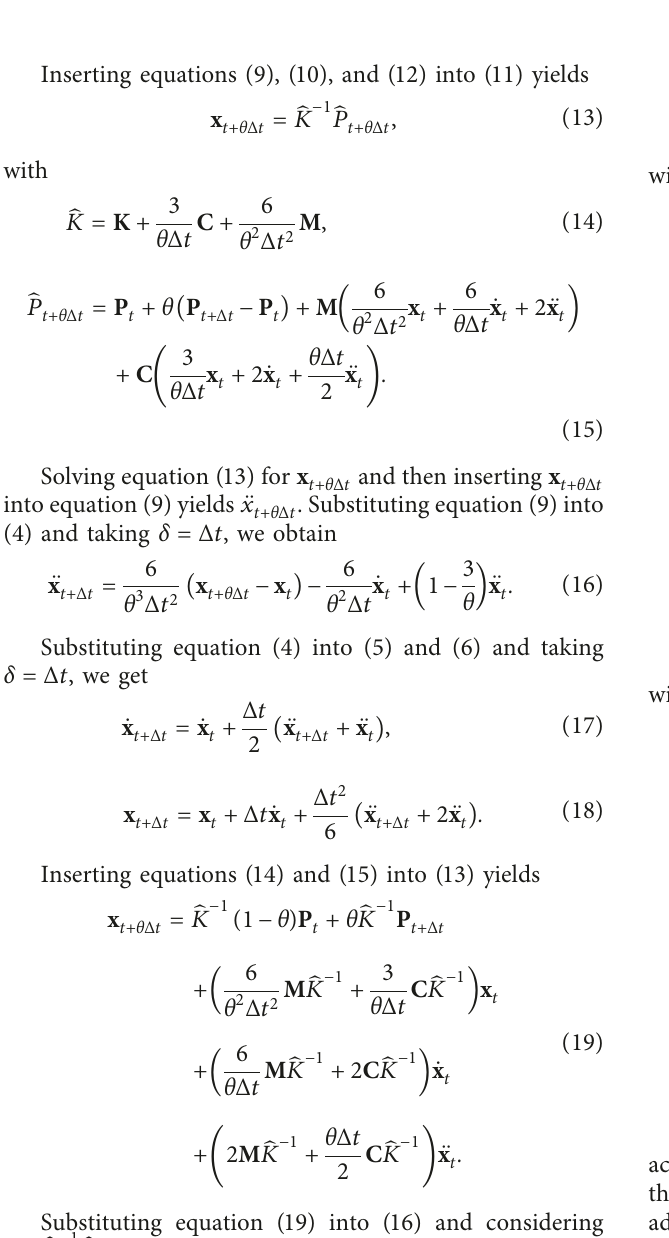
Figure 1: Model of the Wilson- θ